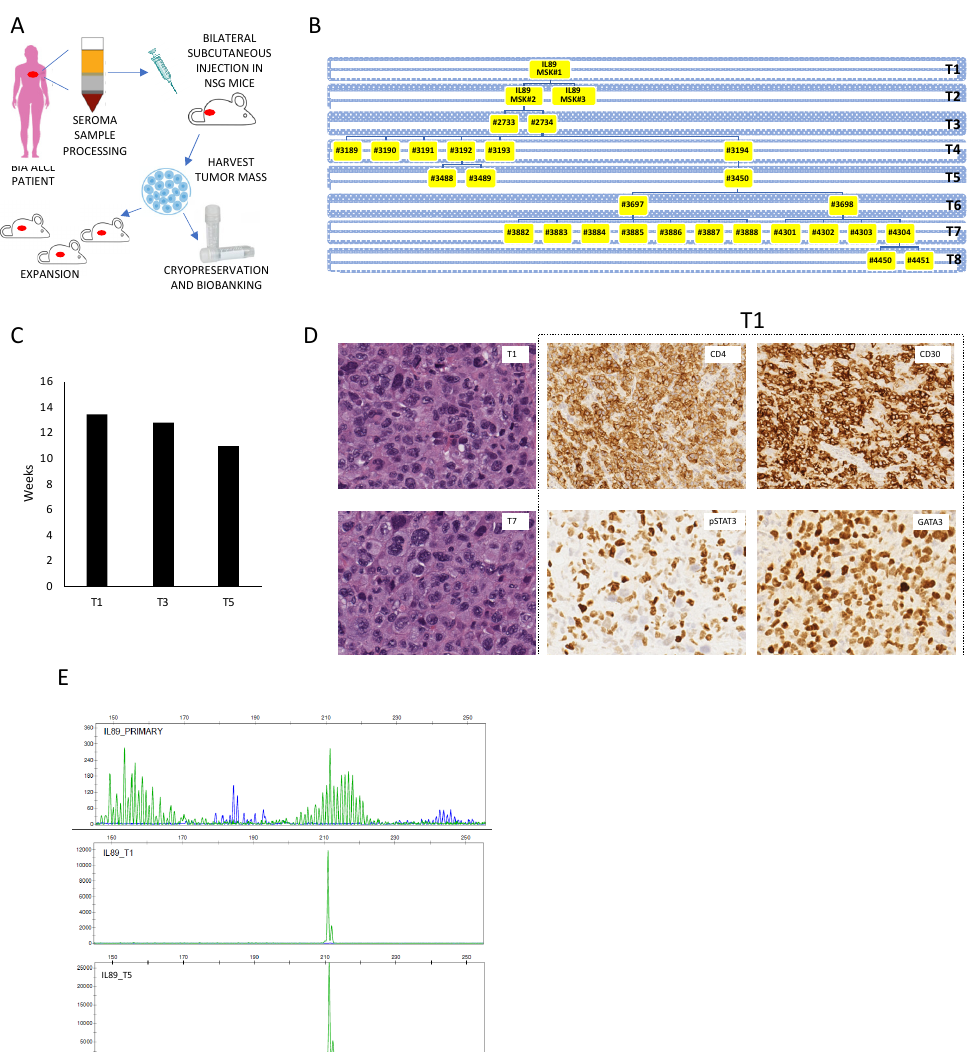
Figure 1. IL89 patient-derived tumor xenograft (PDTX) generation and phenotypical characterization. ( A ) Schematic PDTX generation and expansion workflow. The patient’s material was processed and